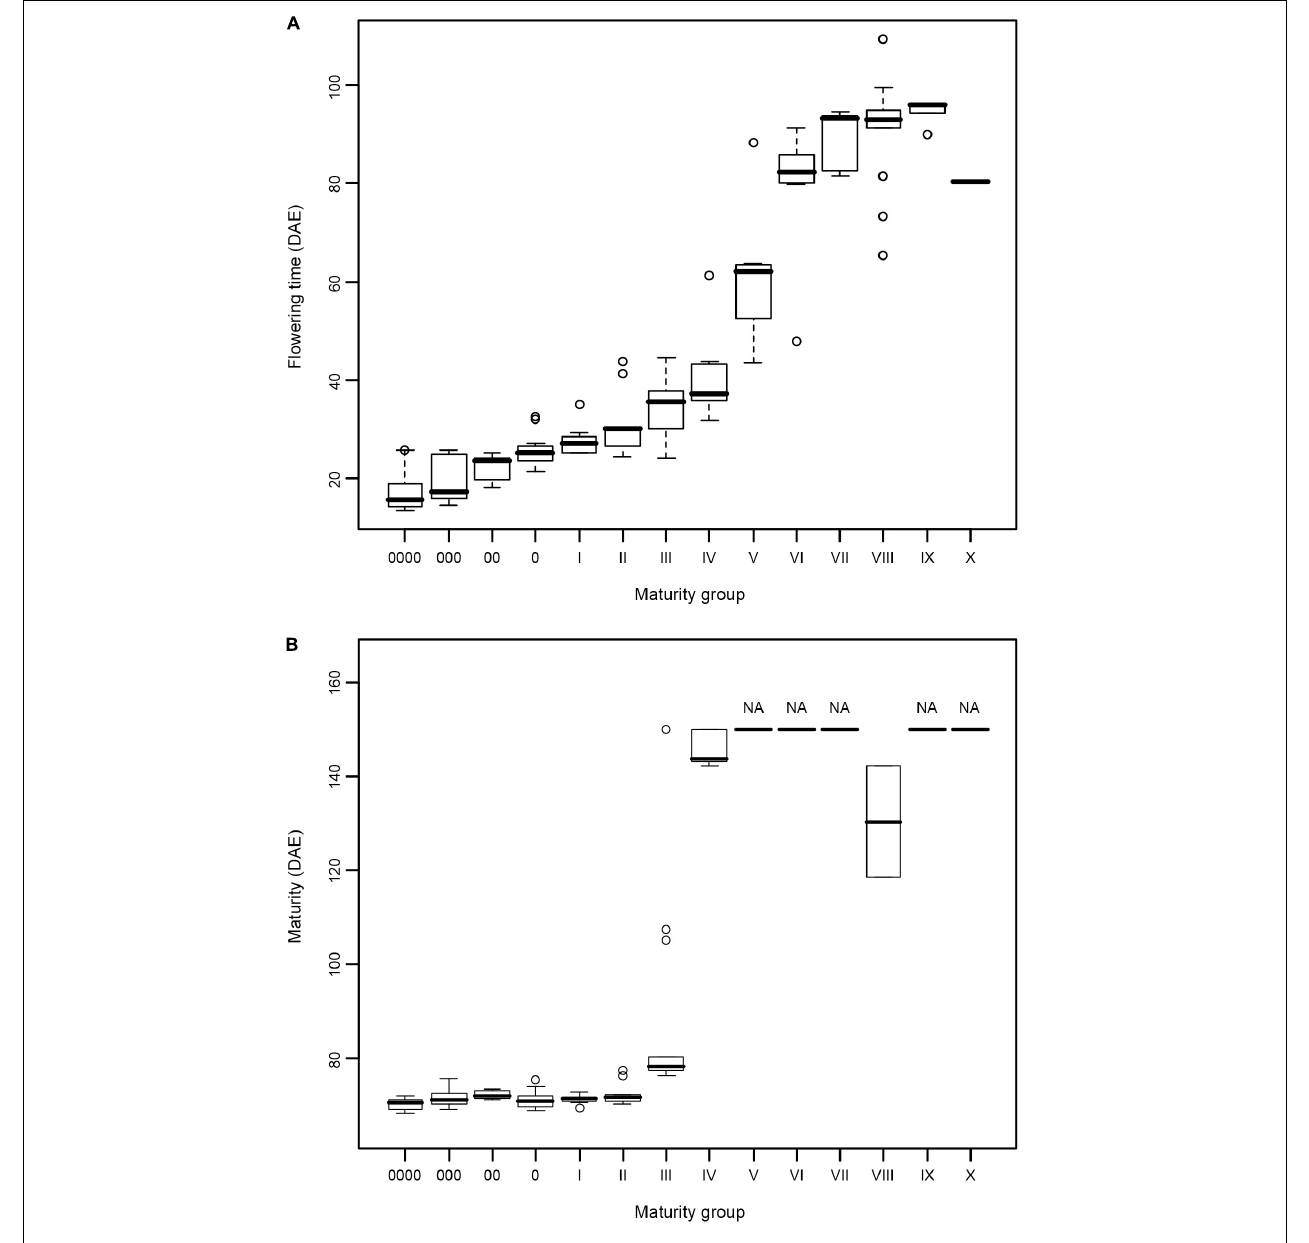
FIGURE 1 | (A,B) Flowering time and maturity of soybean varieties from different maturity groups. Flowering time and maturity data were collected in 2016 from 128 soybean varieties covering 14 maturity groups. DAE, days after